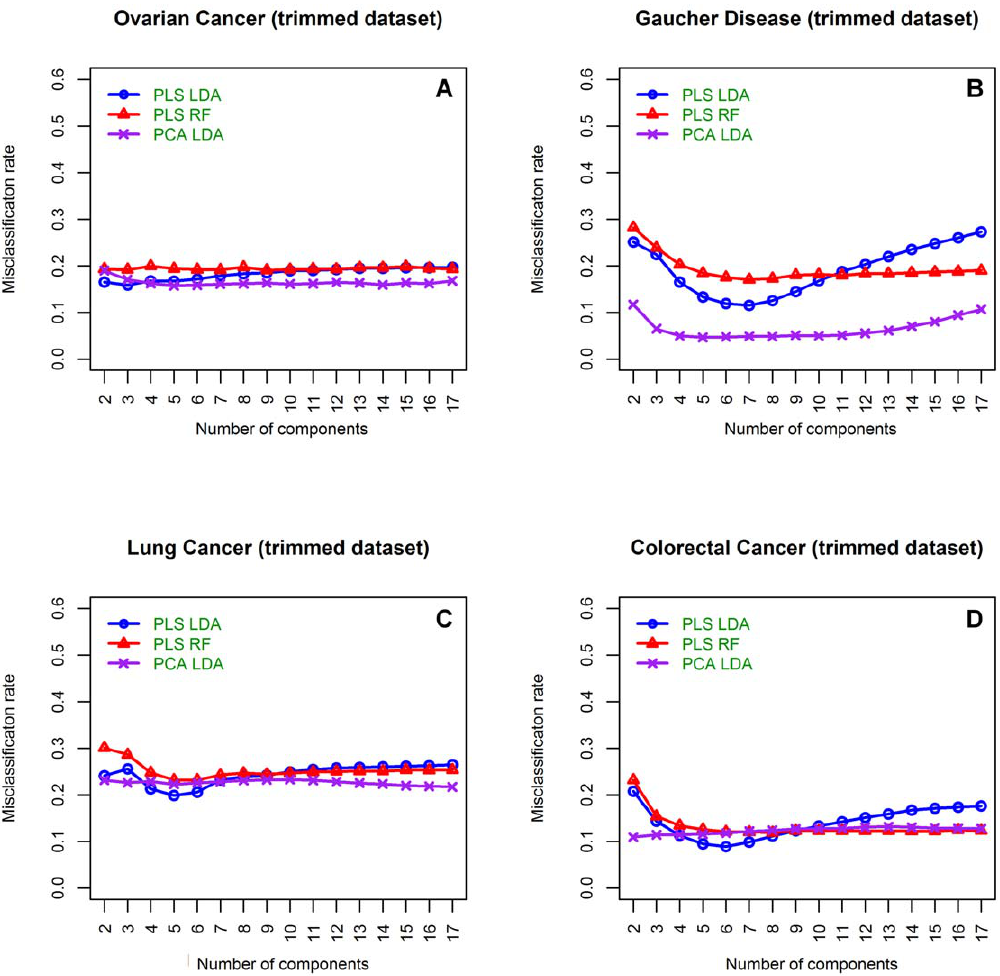
Figure 2. Misclassification rates of dimension reduction classifiers using the trimmed datasets. Mean misclassification rates for each of the dimension reduction-based methods using the trimmed dataset to build the classification model. A ) Is from the OC dataset [16], B ) is from the Gaucher disease dataset [46], C ) is from the LC datasets and D ) is from the CRC dataset [14]. Blue circles illustrate PLS-LDA classification results, red triangles are from a PLS-RF classifier and purple crosses show results obtained from a PCA-LDA classifier.